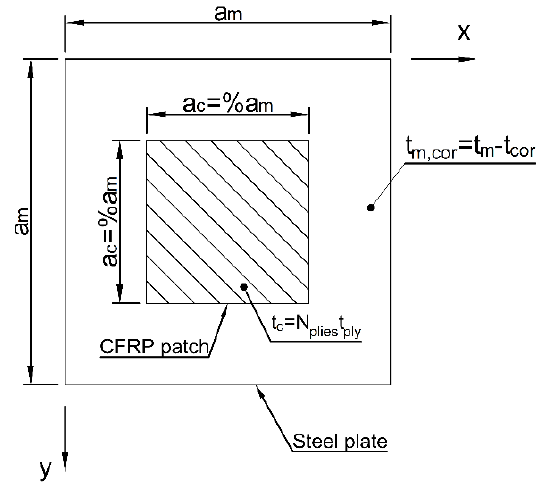
Figure 4. Schematic of plate’s repair design with CFRP patch.